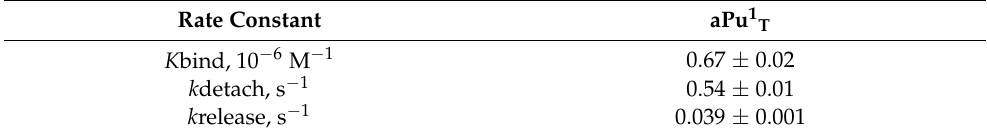
Table 1. Rate constants for the interaction of Nfo with aPu 1T.